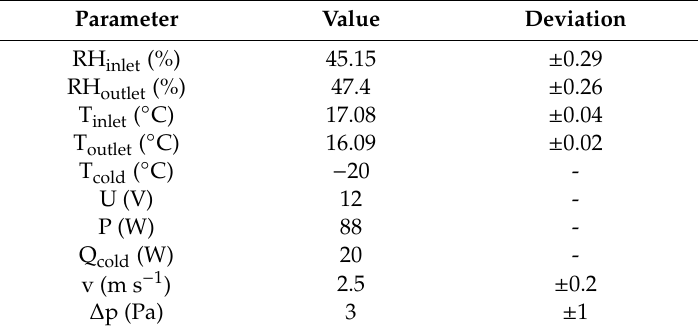
Table 6. Measured average values of the quasi-steady